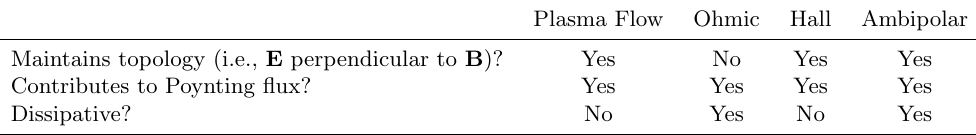
Table 1: Summary of the impact of various effects present in MHD of partially ionized plasmas. Plasma Flow Ohmic Hall Ambipolar Maintains topology (i.e., E perpendicular to B )?